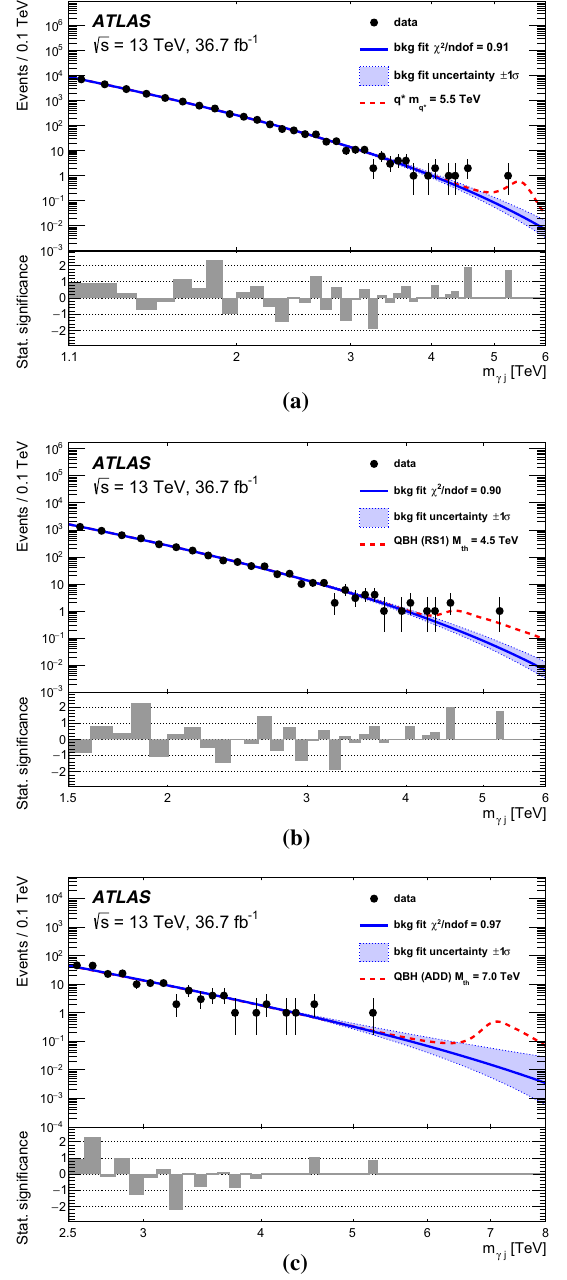
Fig. 4 Distributions of the invariant mass of the γ + jet system of the √ s = 13 TeV and fits to observed events (dots) in 36 . 7 fb − 1 of data at thedata(solidlines)underthebackground-only hypothesisforsearches in the a excited quarks, b QBH (RS1) with n = 1 and c QBH (ADD) with n = 6 models. The ± 1 σ uncertainty in the background prediction originating from the uncertainties in the fit function parameter values is shownasashadedbandaroundthefit.Thepredictedsignaldistributions (dashed lines) for the q ∗ model with m q ∗ = 5.5 TeV and the QBH model with M th = 4.5 (7.0) TeV based on RS1 (ADD) are shown on top of the background predictions. The bottom panels show the bin-by- bin significances of the data–fit differences, considering only statistical uncertainties